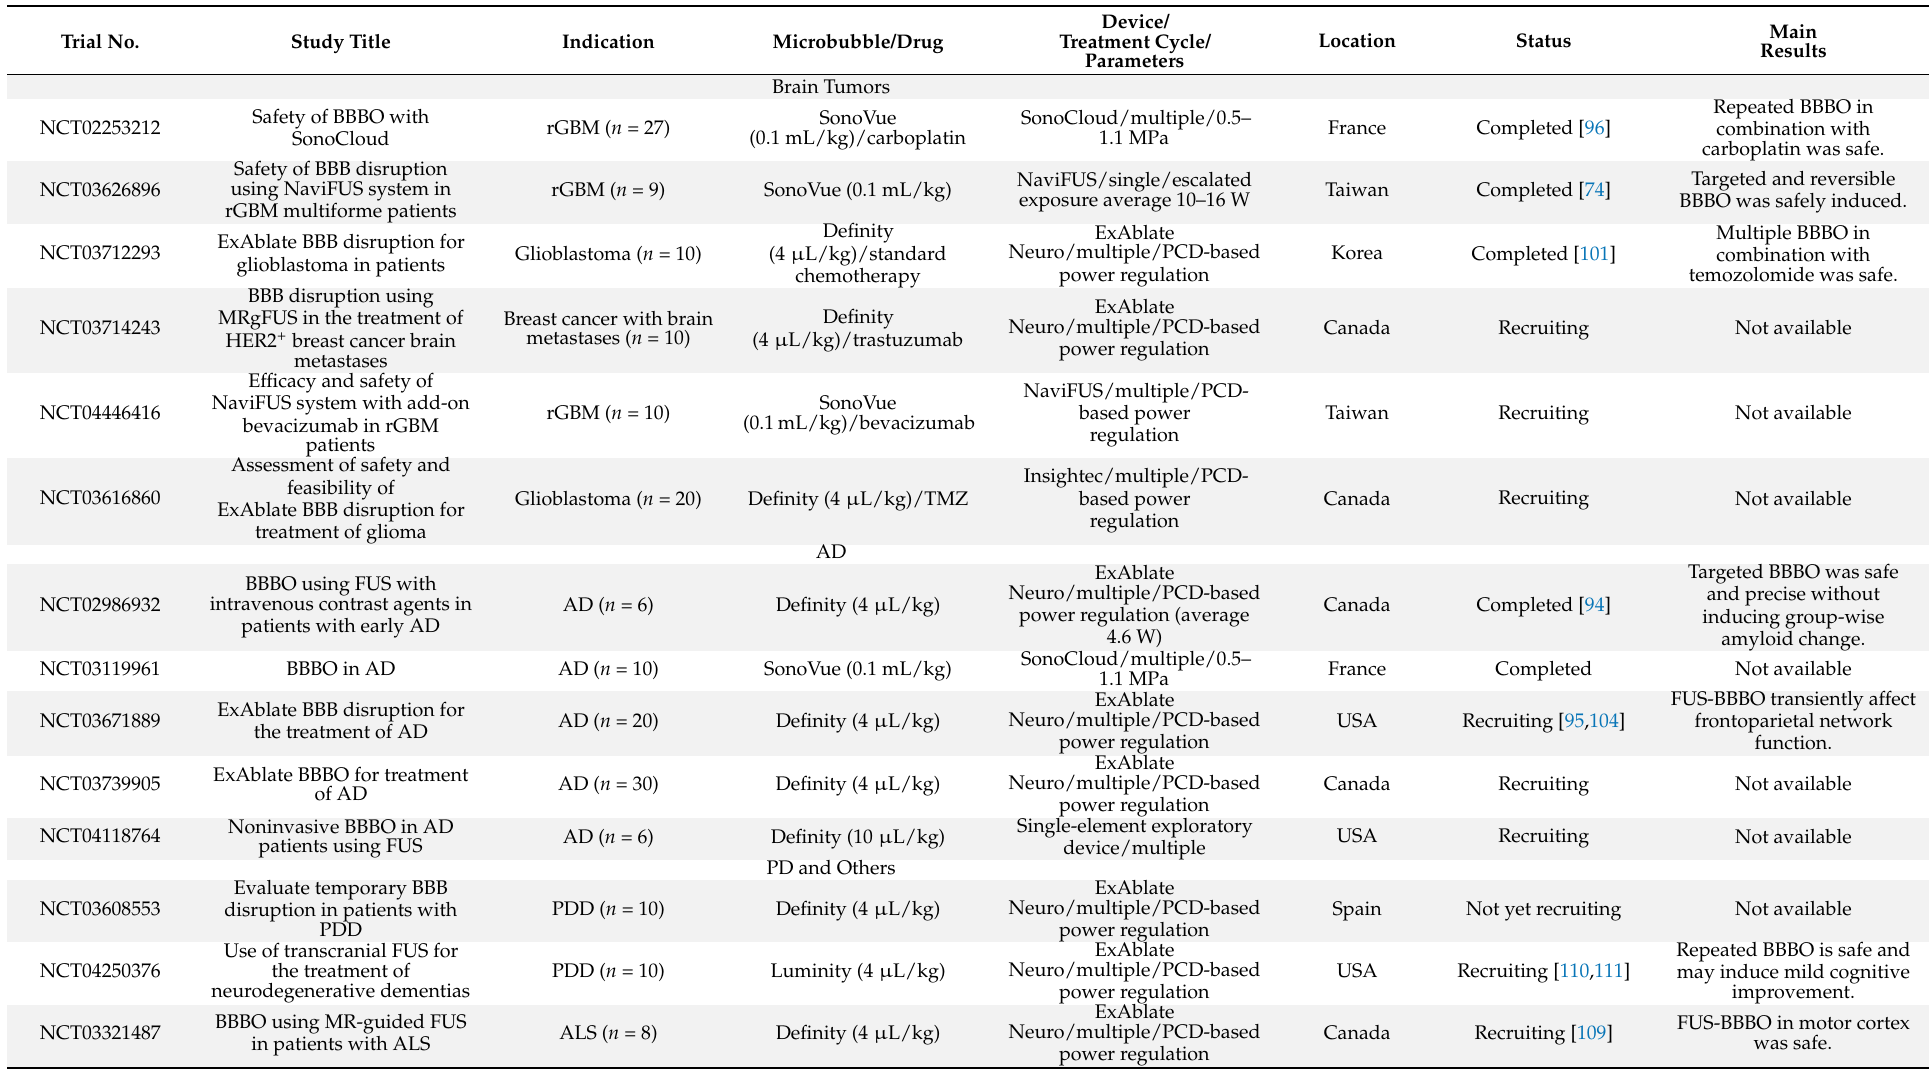
Table 2. Summary of completed and ongoing clinical trials of